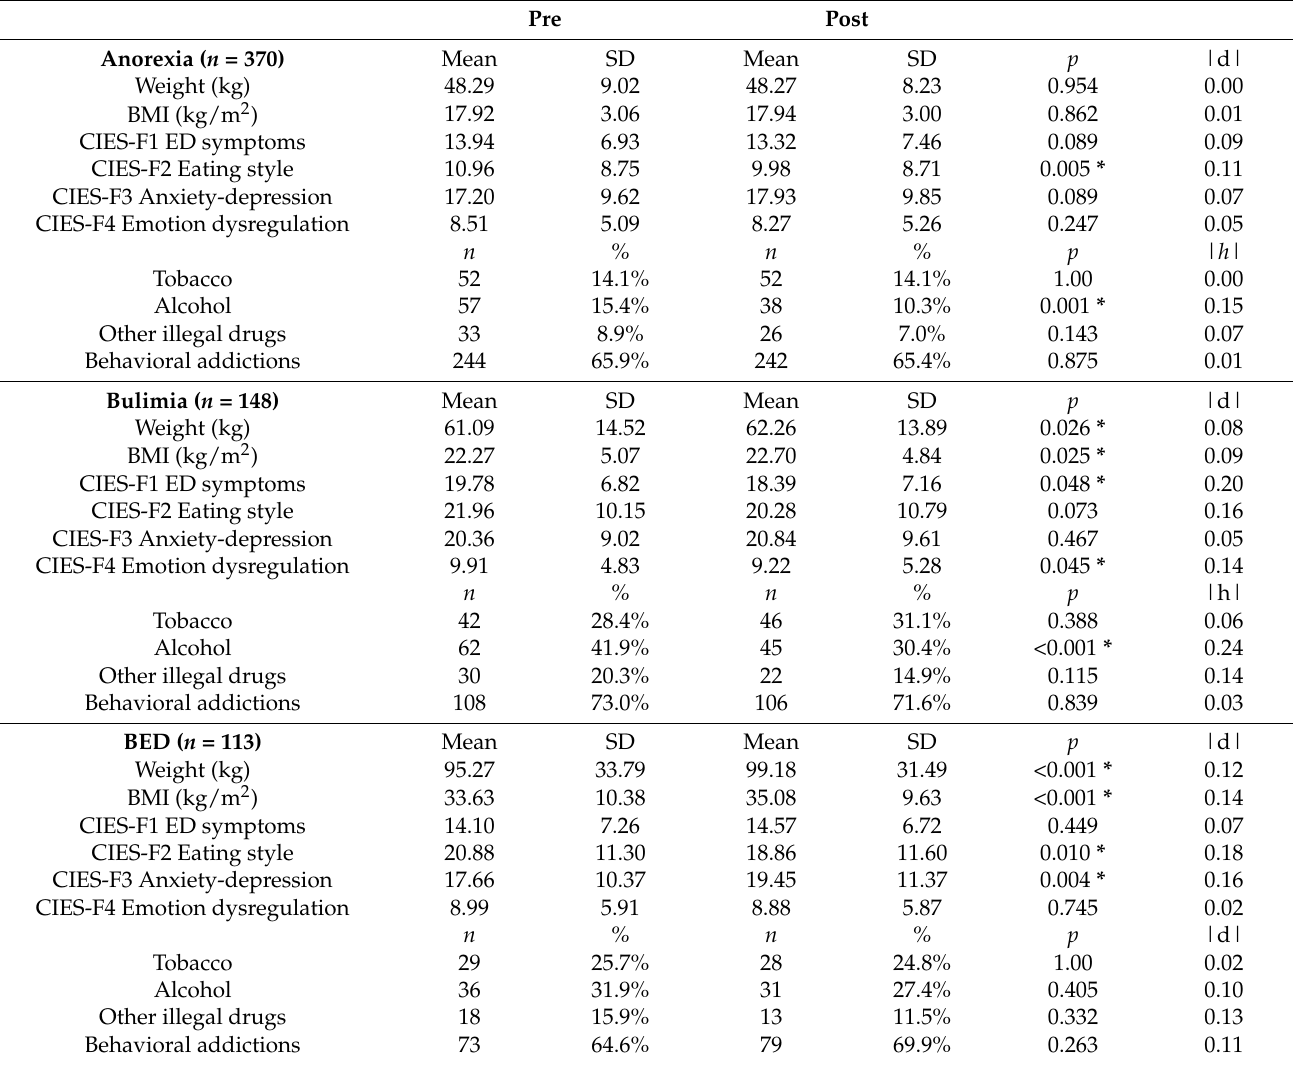
Table 1. Assessment of the post-pre changes stratified by ED